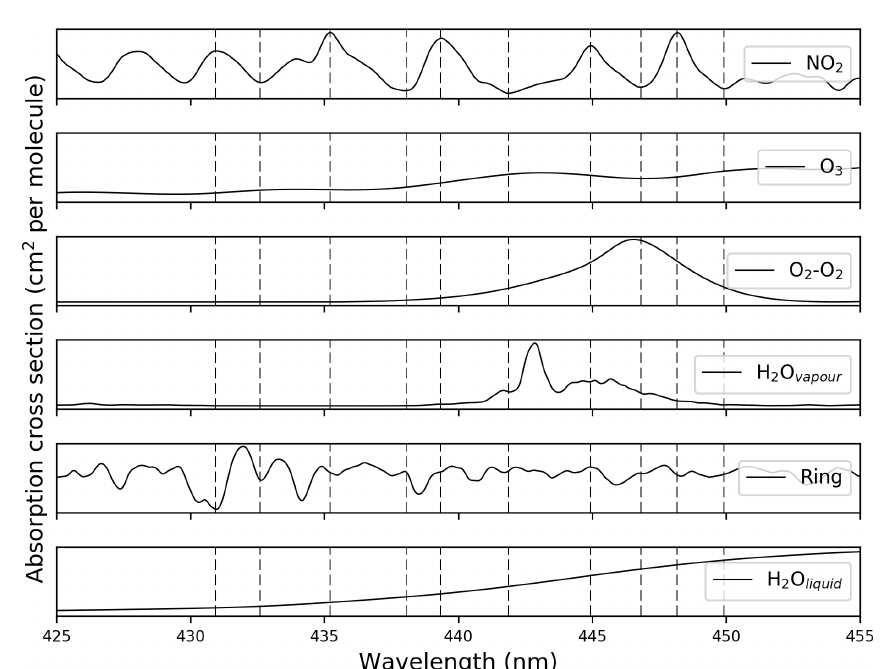
Figure 1. Flow diagram of the data processing used prior to the DW-DOAS retrieval.